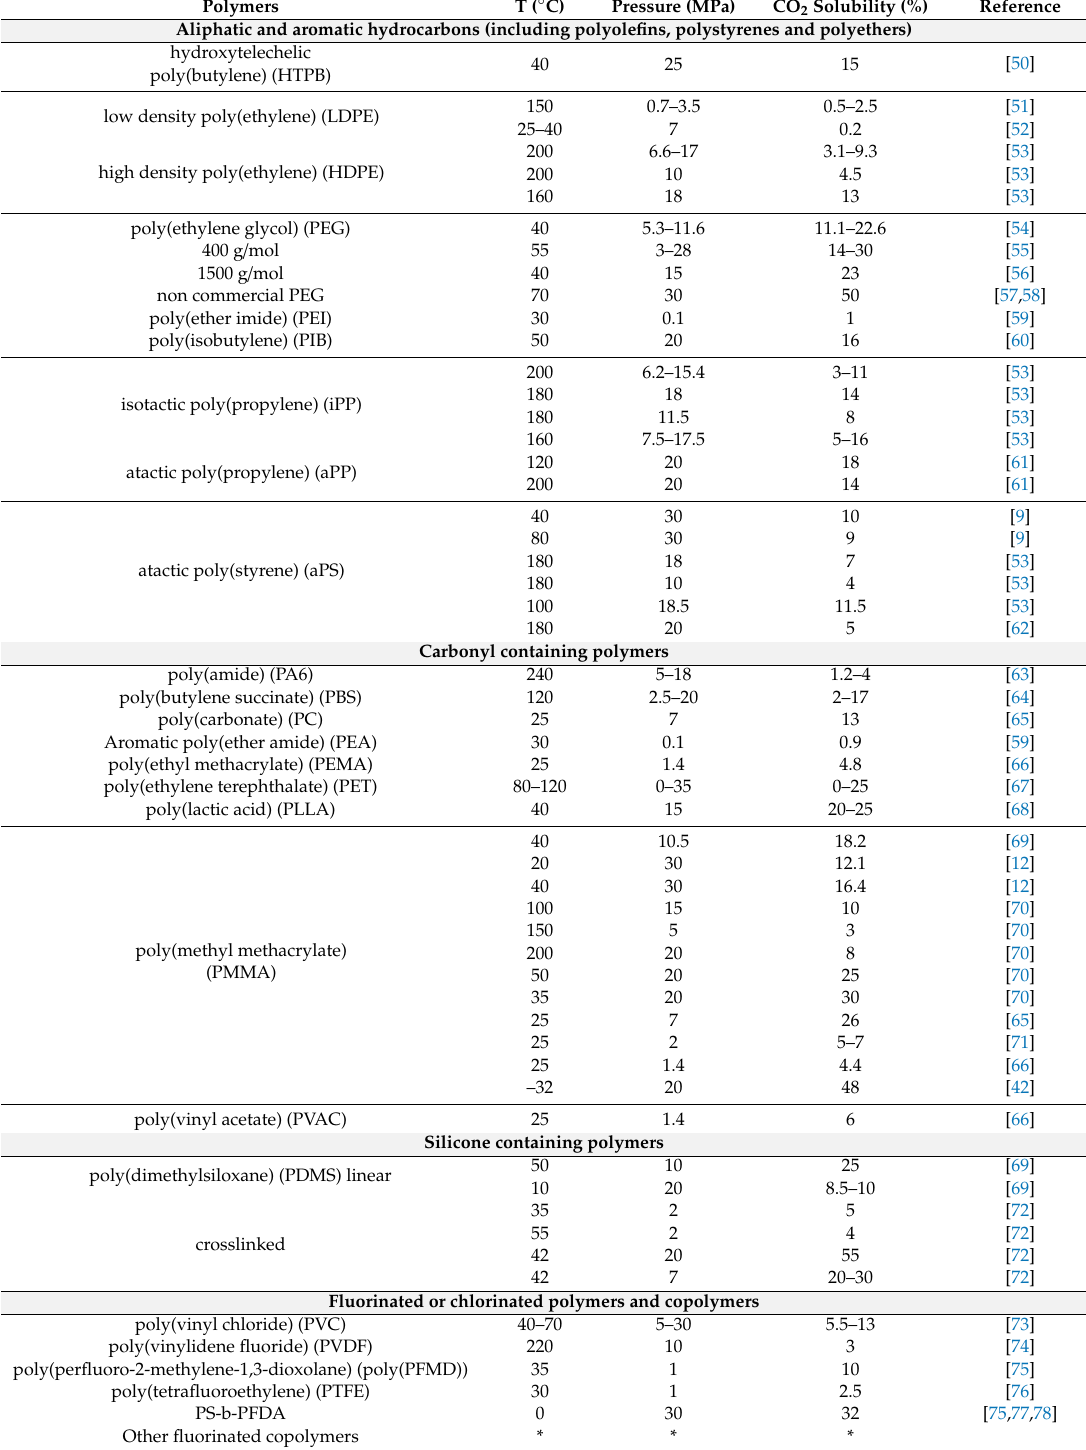
Table 1. CO 2 solubility in polymers: Summary of literature values expressed in % CO 2 uptake. Polymers T ( ◦ C) Pressure (MPa) CO 2 Solubility (%) Reference Aliphatic and aromatic hydrocarbons (including polyolefins, polystyrenes and polyethers) hydroxytelechelic low density poly(ethylene)